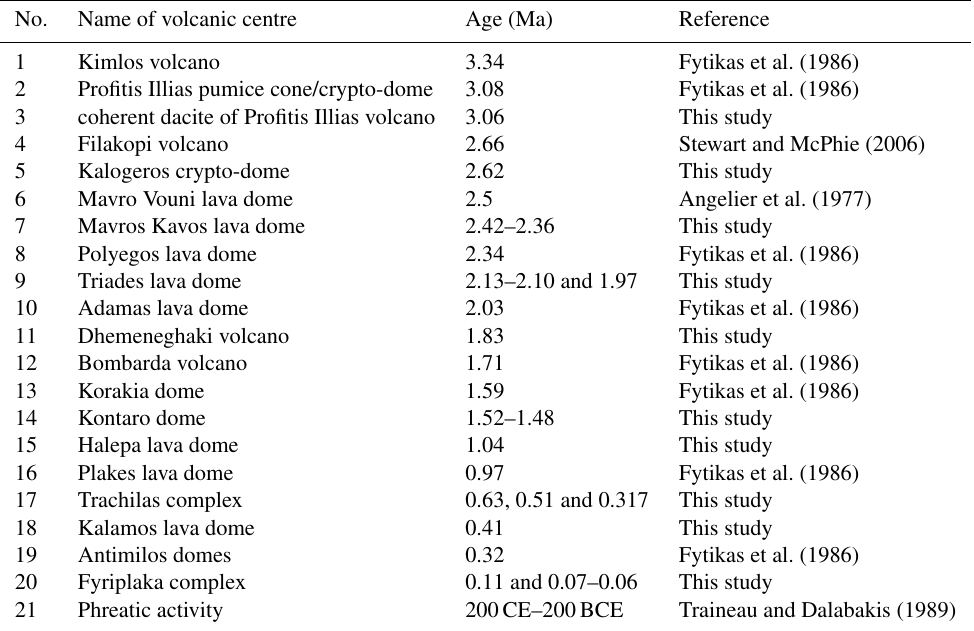
Table 5. Summary of the eruption ages of the Milos volcanic